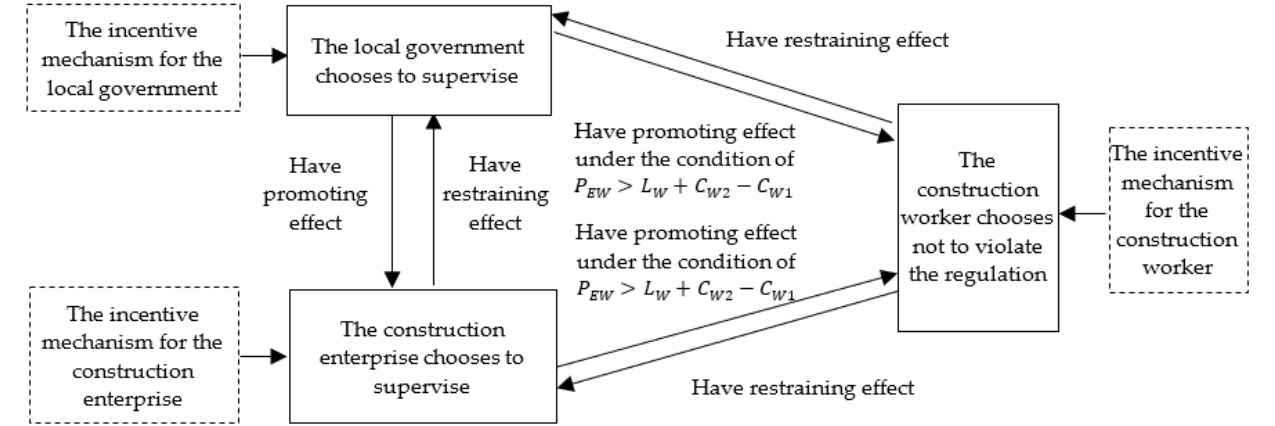
Figure 4. Behavior influence mechanisms among the local government, the construction enterprise, and the construction worker.